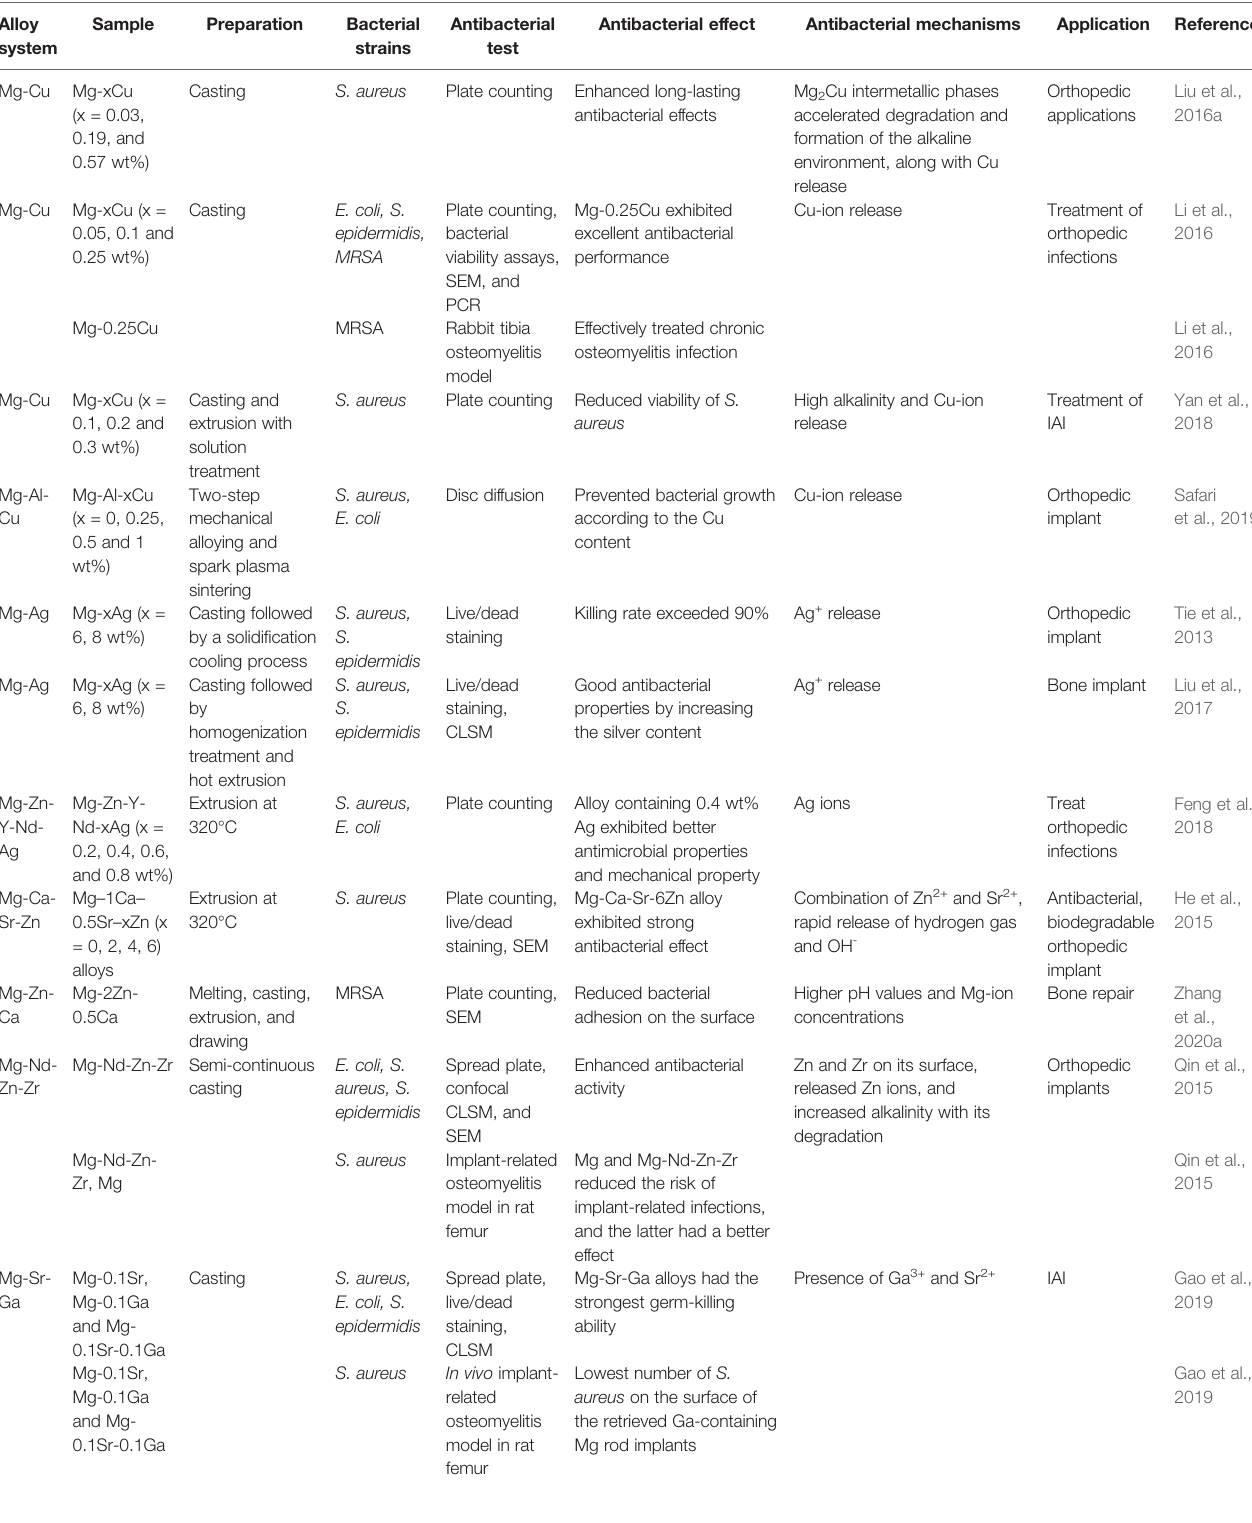
TABLE 3 | Engineered magnesium alloys with antibacterial